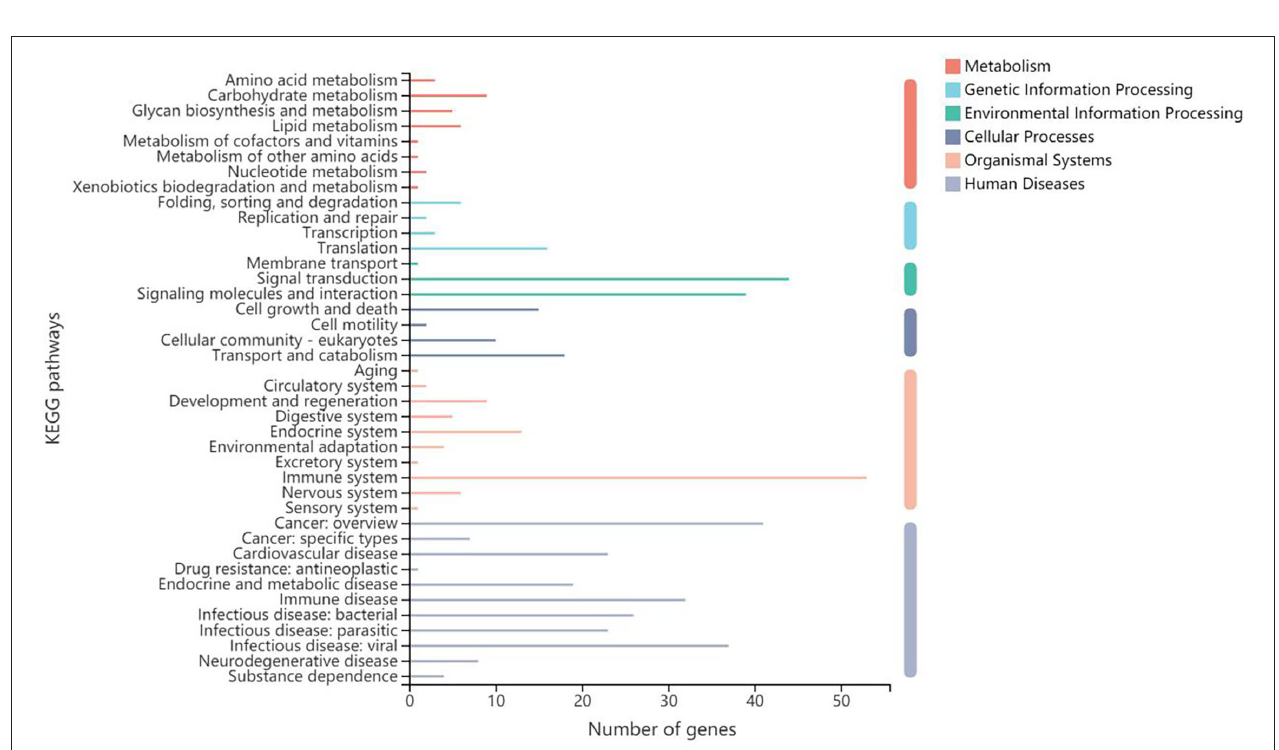
FIGURE 5 | Gene function annotation in